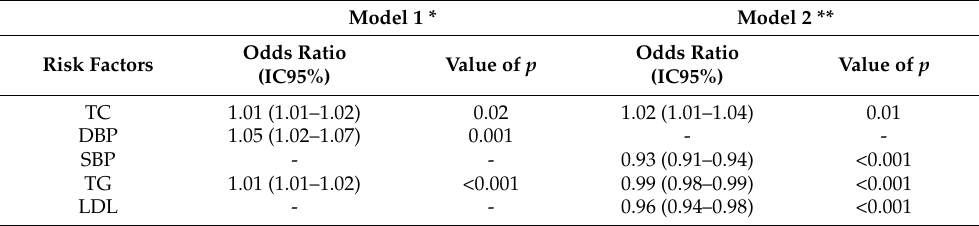
Table 2. Association of cardiometabolic risk factors with the study group (SG). Viçosa-MG, Brazil, 2010 to 2015 ( n =